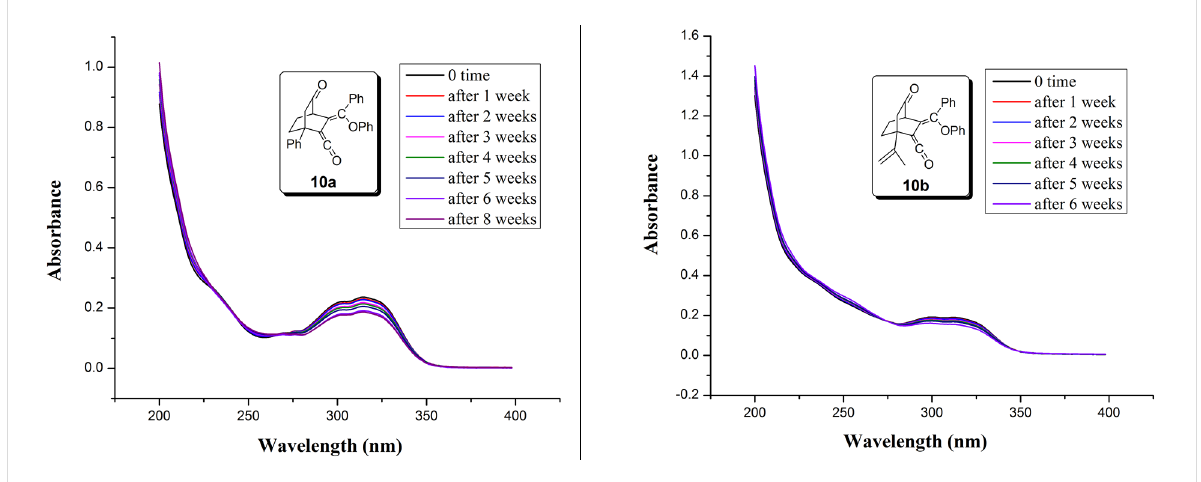
Figure 3: Time-dependent absorption spectra of 10a , b in acetonitrile at rt.